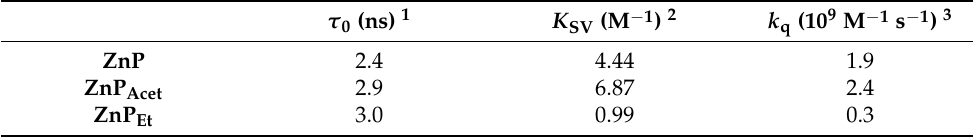
Figure 2. ( a ) Steady-state absorption and emission (inset) spectra of ZnPs in DMF, ( b ) representative fluorescence decay profiles of ZnPs with the addition of BIH (λ ex = 400 nm; λ det = 645, 635, and 620 nm for ZnP , ZnP Acet , ZnP Et , respectively; solid lines are the single exponential fit; see the complete set of decay profiles in Figure S1 of the Supporting Information), and ( c ) Stern-Volmer plot (solid lines are the linear fit). Table 1. Quenching Kinetic Parameters of ZnPs by BIH.